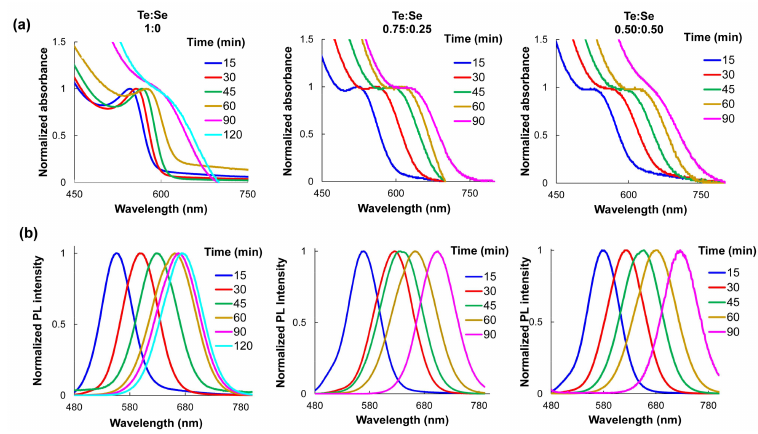
Figure 1. Evolution of ( a ) absorption and ( b ) fluorescence spectra of mercaptopropionic acid (MPA)-capped CdTeSe quantum dots (QDs) in water at pH 8 obtained at different molar ratios of Te:Se (1:0, 0.75:0.25, 0.50:0.50) and different time